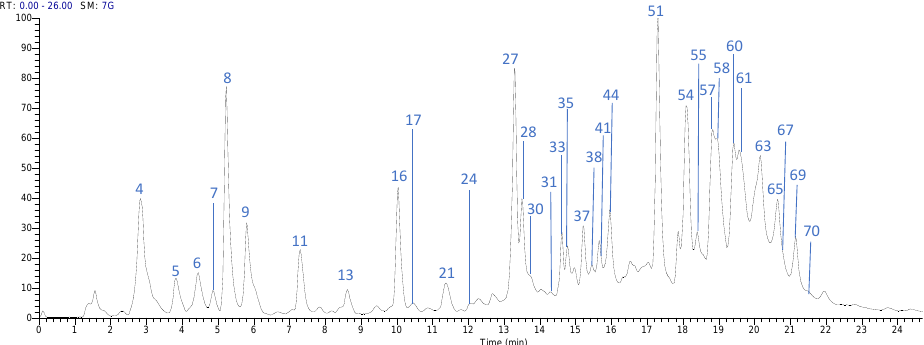
Figure 1. High Performance Liquid Chromatography (HPLC) chromatogram of Mangifera indica Tommy Atkins cultivar skin extract, in a Hypersil Gold AQ RP-C18 column (200 mm × 2.1 mm × 1.9 µm) using an LTQ Orbitrap XL Mass spectrometer (Thermo Scientific™, Walthman, MA, USA) in a mass range from 100 to 2000 amu.